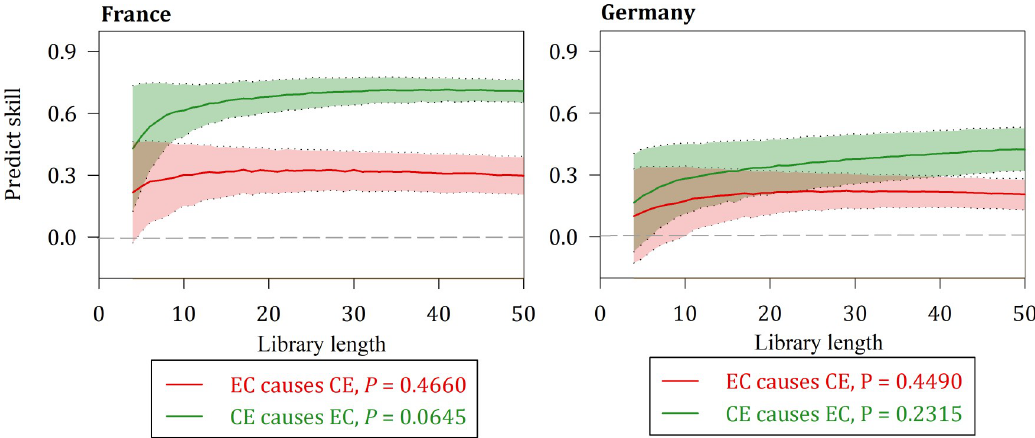
Fig 5. Causality between EC and CE for France and Germany.